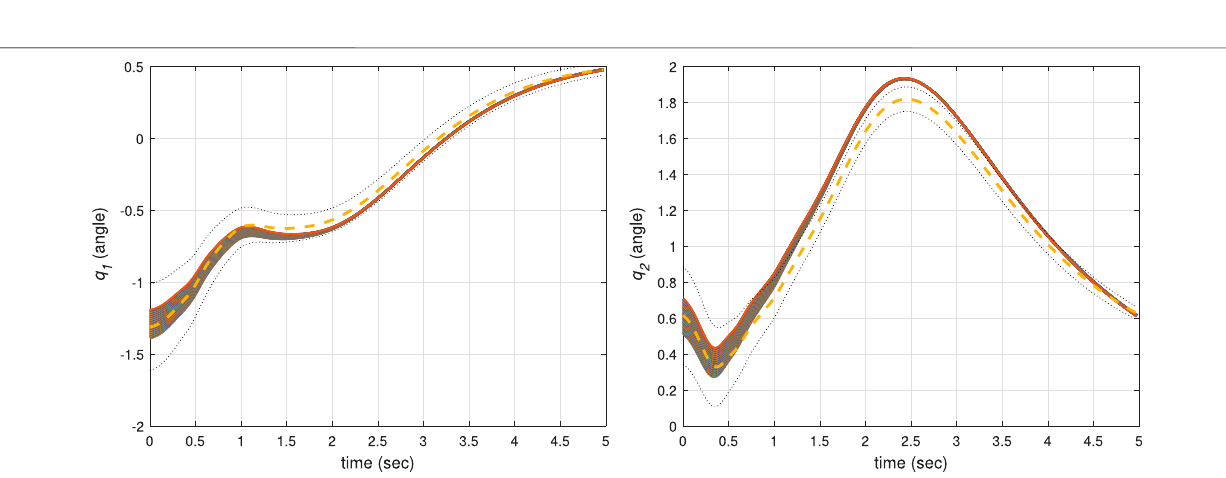
Figure 11 . We consider two different scenarios. In scenario 1, p = 200, which gives higher importance to the CLF. For scenario 2, p sci = 0.001, which implies that the design interest and priority is robot can effectively track the mean of ProMP and